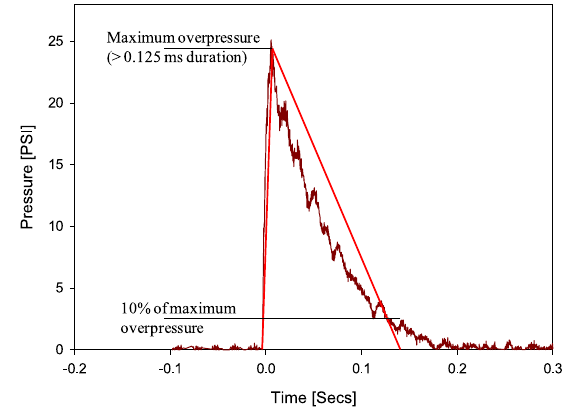
Table 5. Results of predicted maximum and final deflections for plates at centre of plate loaded to nominally 50 psi by energy